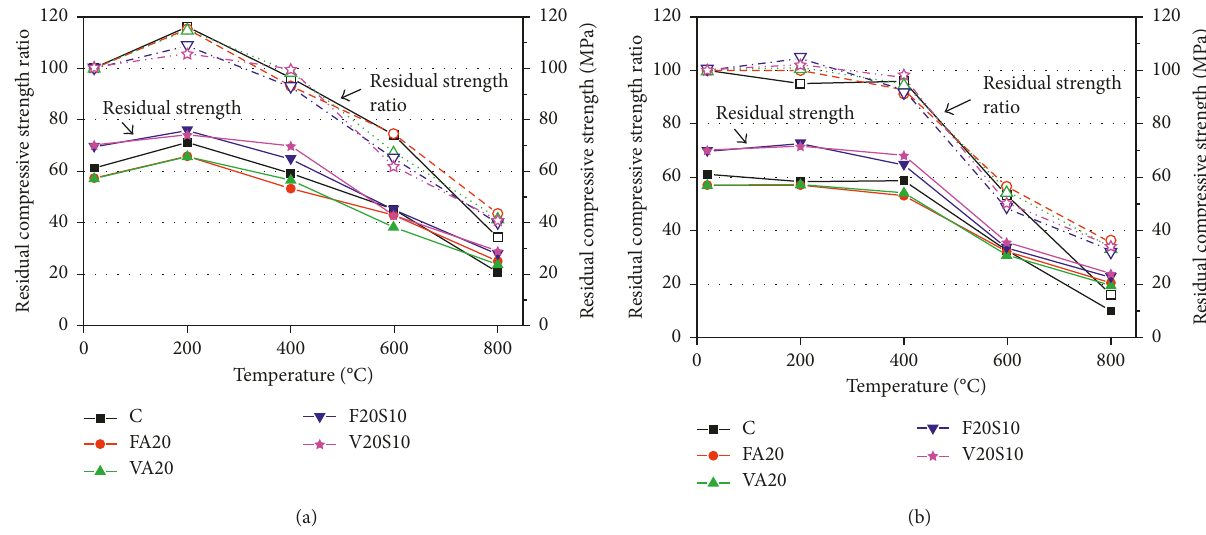
Figure 6: Influence of different elevated temperatures on residual compressive strength of CM and mortar containing cement-replacing materials: (a) air-cooled; (b)